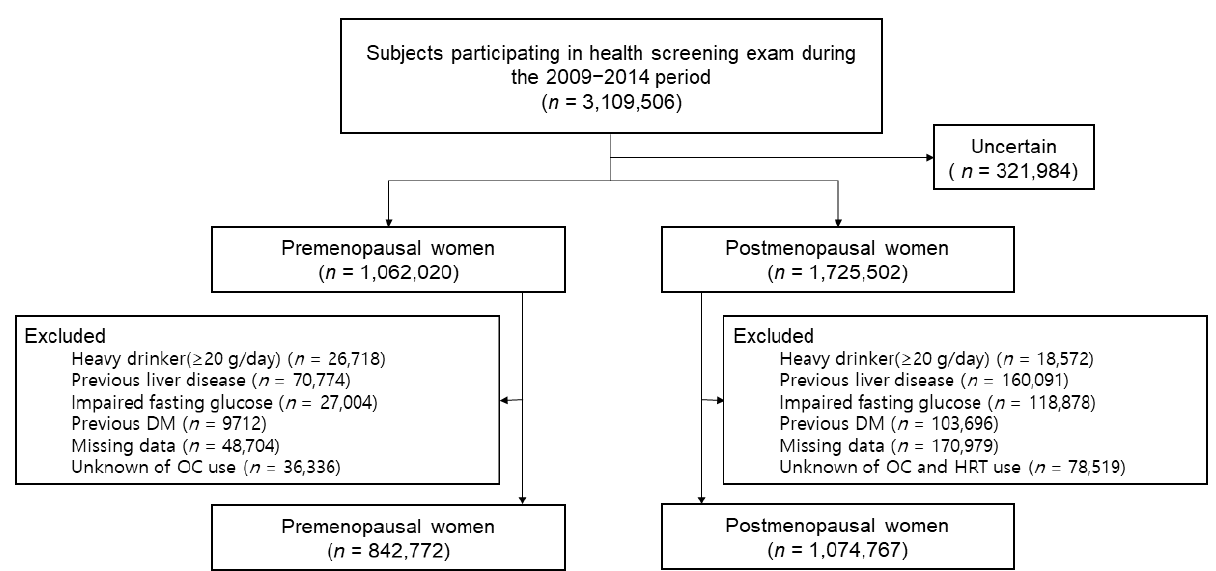
Figure 1. Flow chart of the study